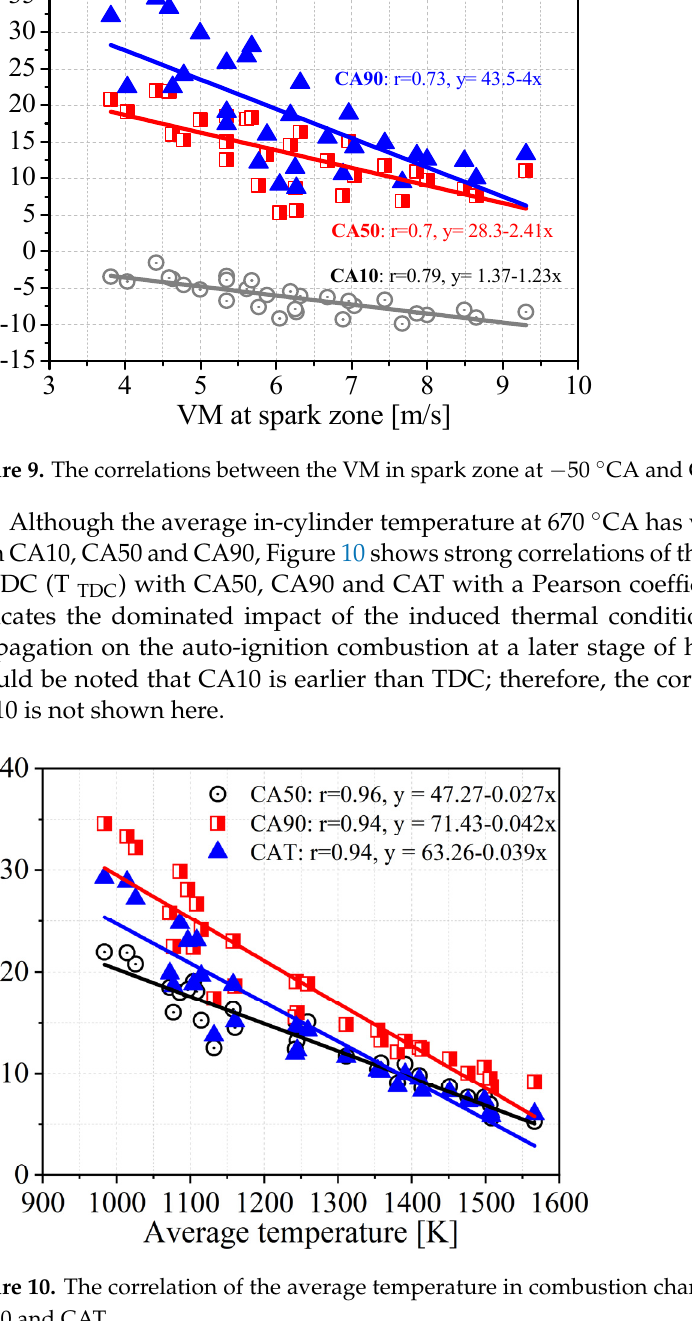
Figure 10. The correlation of the average temperature in combustion chamber at TDC with CA50, CA90 and CAT. In order to understand the combustion process that is influenced by in-cylinder flow motion and temperature, five typical combustion cycles with both strong and weak com- bustion processes were selected for further analysis. The corresponding mass fraction burned (MFB) traces are shown in the Figure 11. As shown in the figure, the combustion